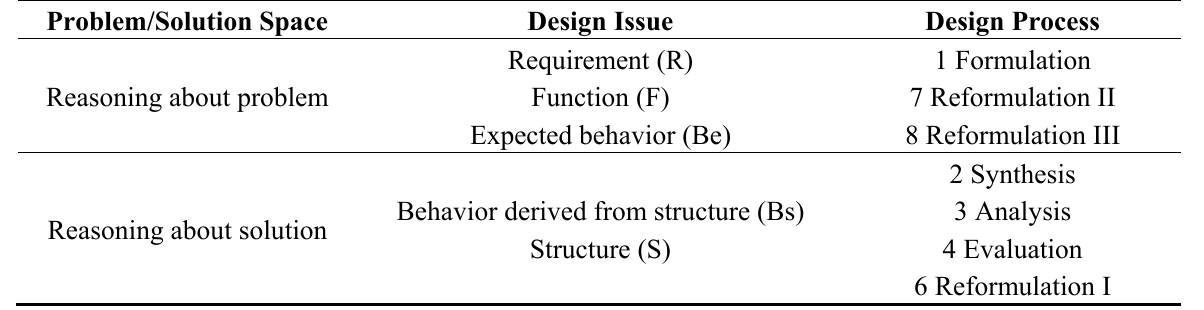
Table 1. Mapping FBS design issues and processes onto problem and solution spaces